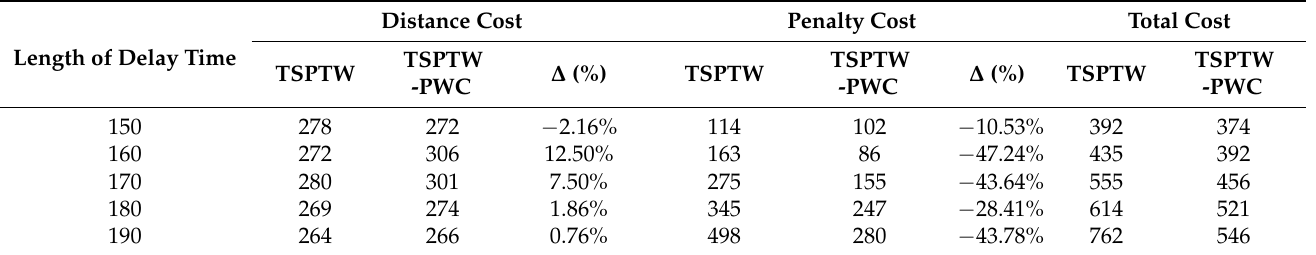
Table 4. Sensitivity analysis of the length of delay